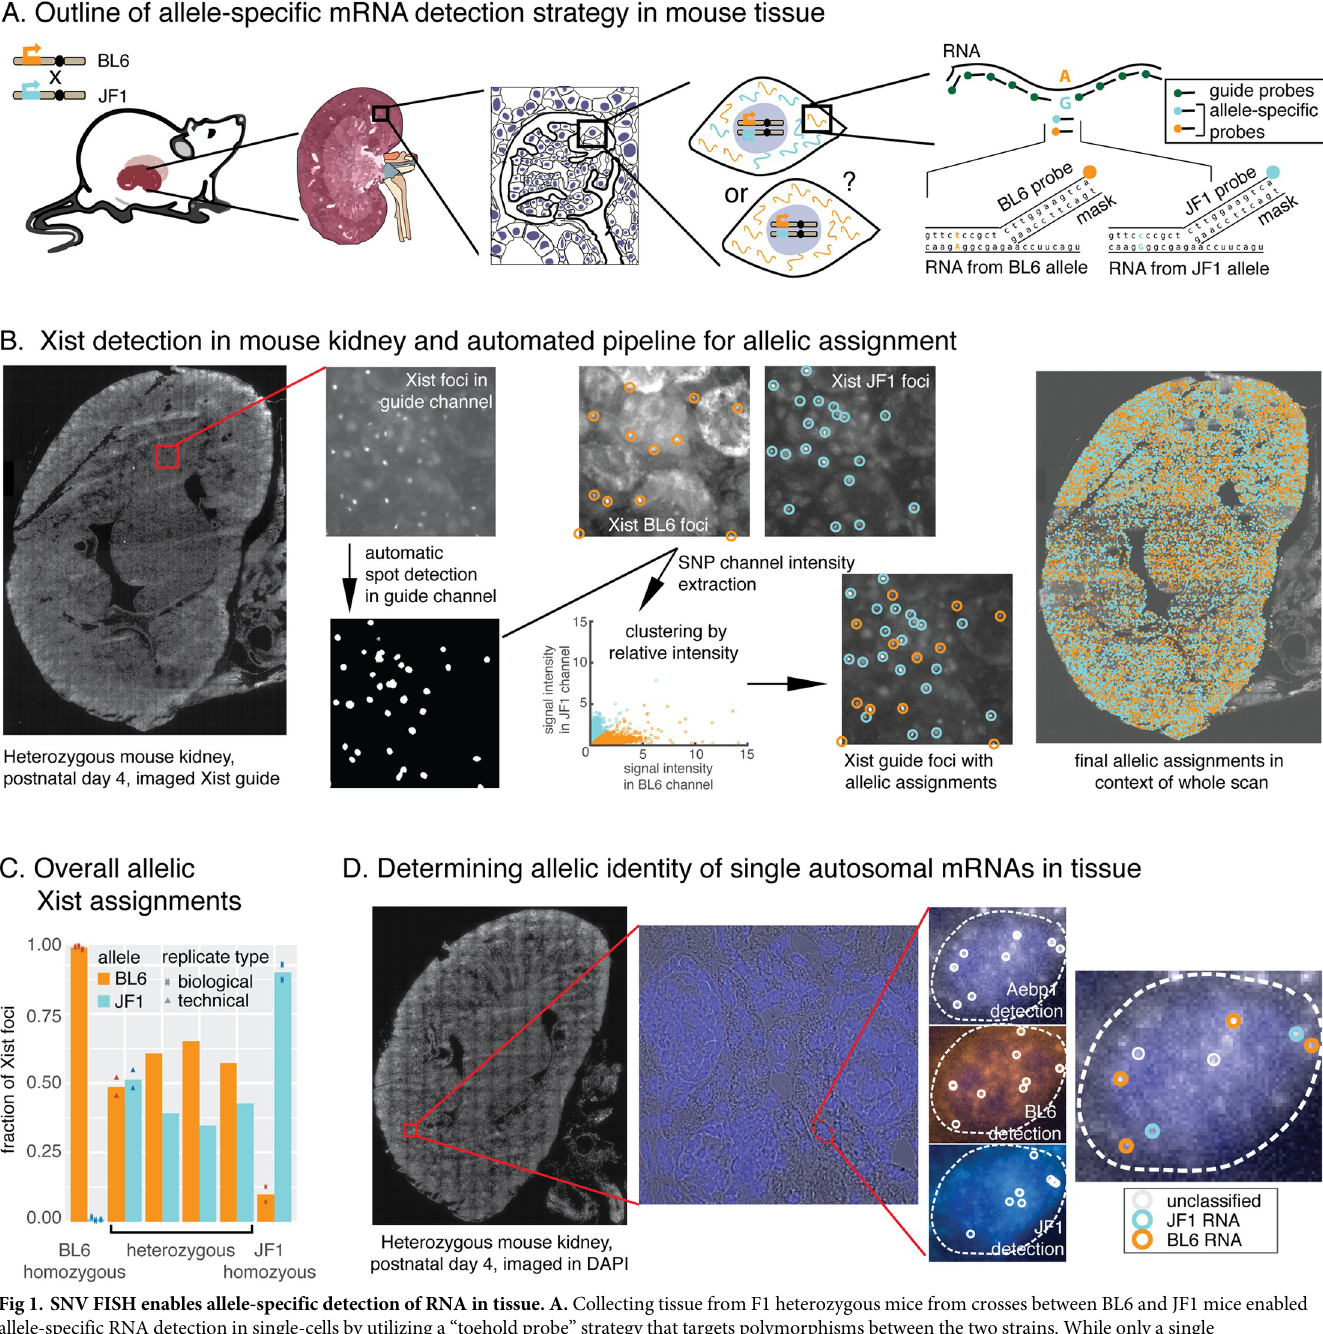
PLOS Genetics | https://doi.org/10.1371/journal.pgen.1007874 January9, 2019 4 /